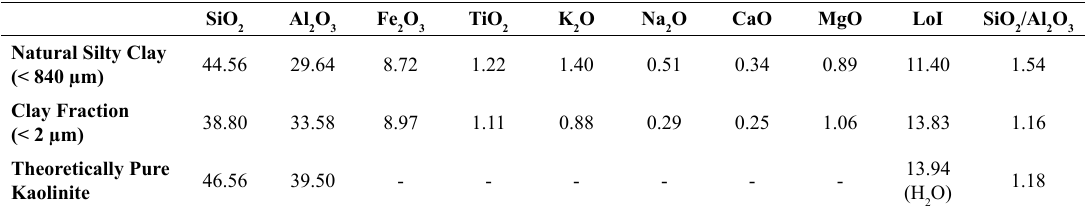
Table 1. Chemical composition of the natural clay and its clay fraction (wt.